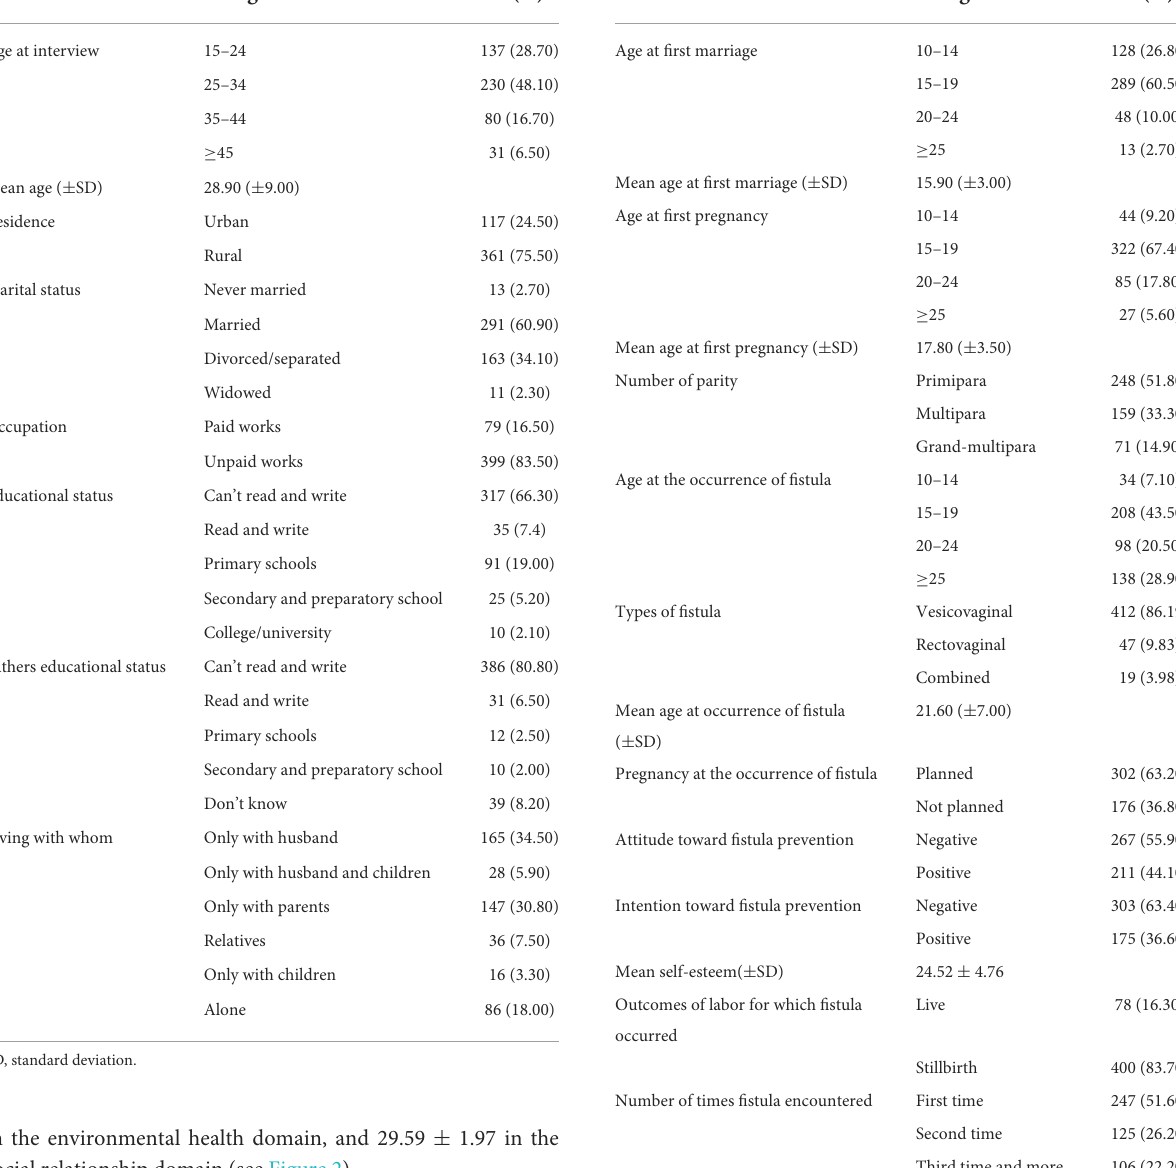
TABLE 1 Socio-demographic characteristics of women with obstetric fistula in Ethiopia, 2019 ( n = 478).